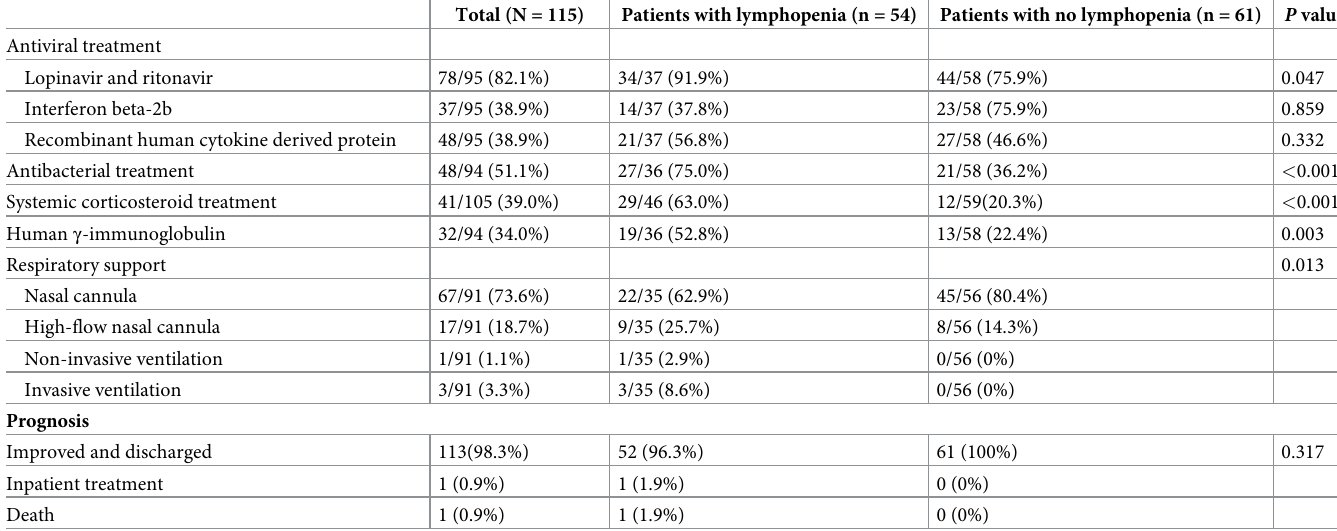
lymphocyte counts. The median albumin level was 36.13 g/L (IQR [28.12–44.52]) in patients with lymphopenia, which was significantly less than patients with no lymphopenia (P = 0.001). More patients in the lymphopenia group had elevated lactate dehydrogenase (LDH) levels (187.7 U/L [IQR 88.2–463.8] vs. 152.4 U/L [IQR 107.1–379.7], P = 0.002). Inflammatory indi- cators, such as C-reactive protein (CRP, median 13.07 mg/L [IQR 88.2–463.8]) and erythro- cyte sedimentation rate (median 35.5 mm/h [IQR 3.0–552.0]) were elevated. However, both indicators were even higher in patients with lymphopenia (P = 0.005 and 0.044,